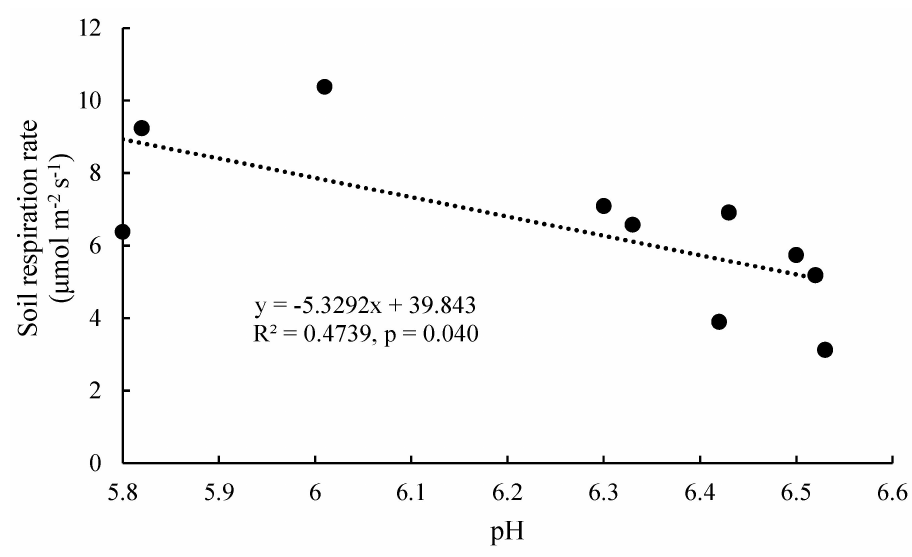
Figure 6. The relationship between soil pH and soil respiration rate.